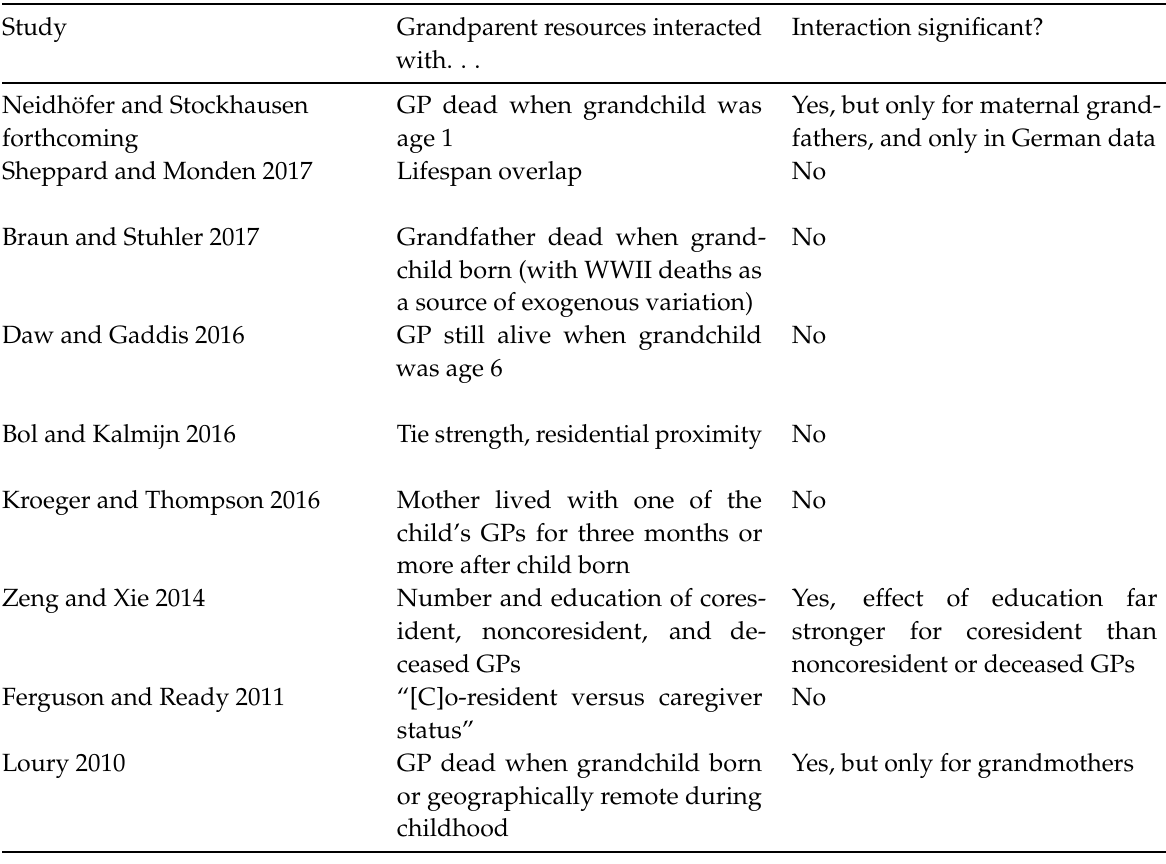
Table 1: Studies testing interactions with grandparental likelihood of contact.